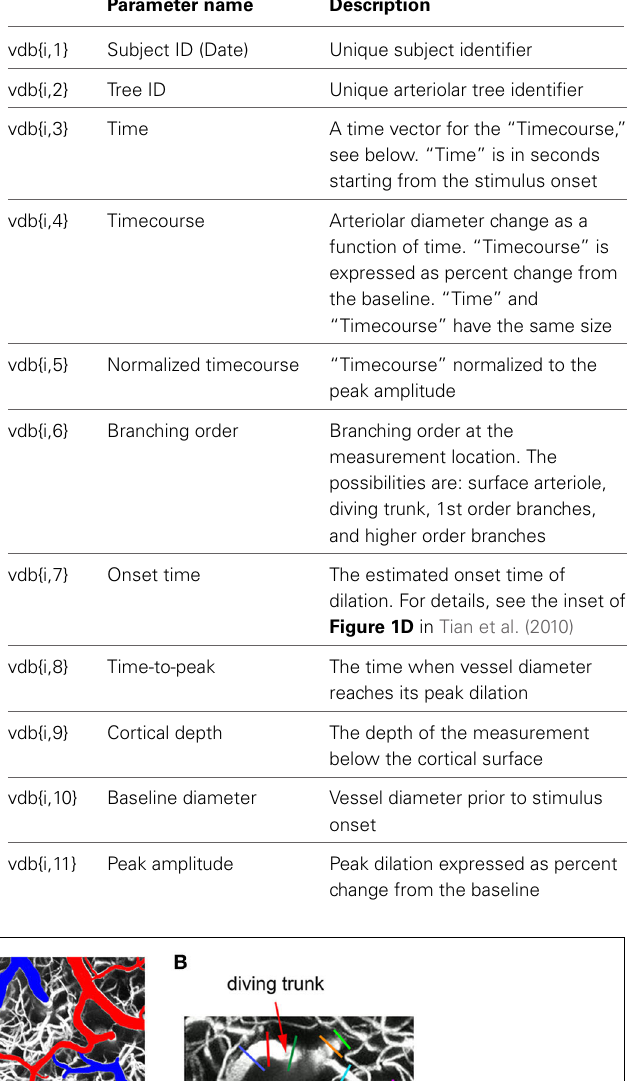
Table 1 | Database structure and naming conventions.